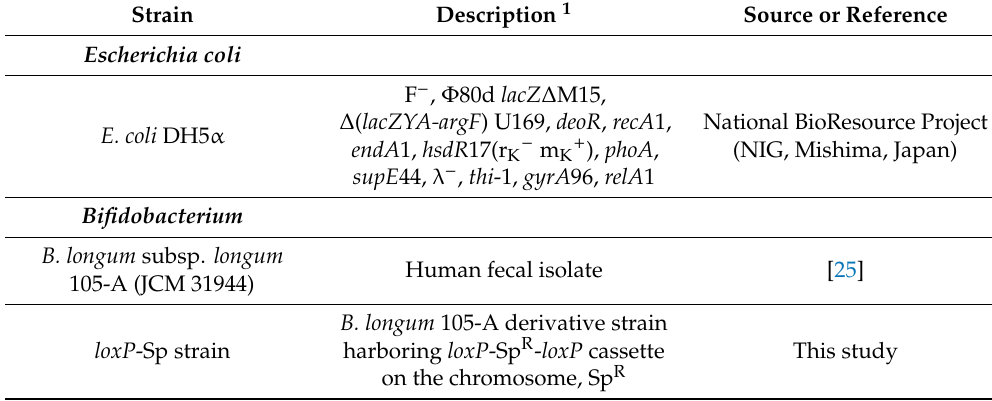
Table 1. Representative bacterial strains used in this